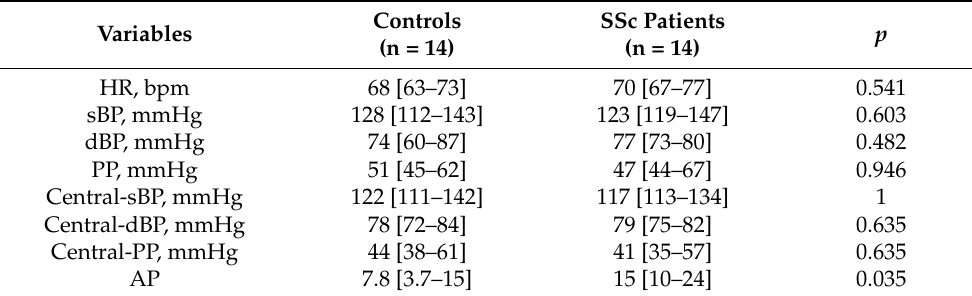
Table 2. Peripheral and central hemodynamic determinations of the study